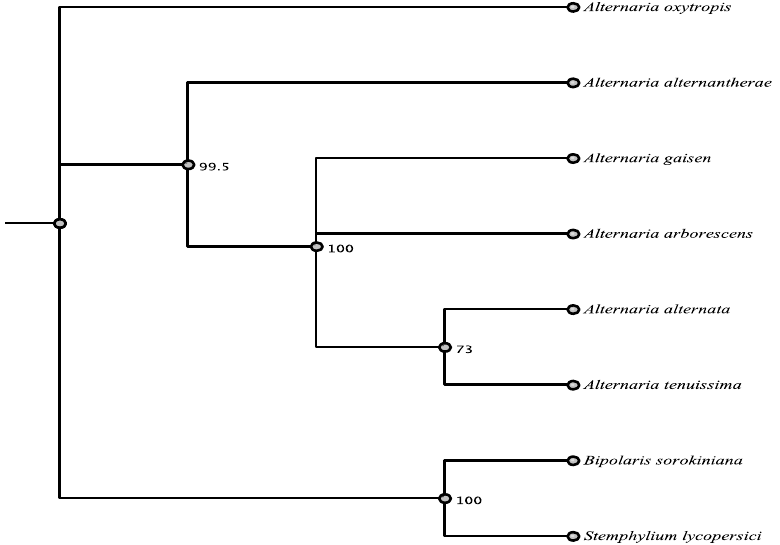
Figure 8. Maximum parsimony tree (MUSCLE alignment and 1000 replicates). Stemphylium lycoper- Scheme 40283 sequence.